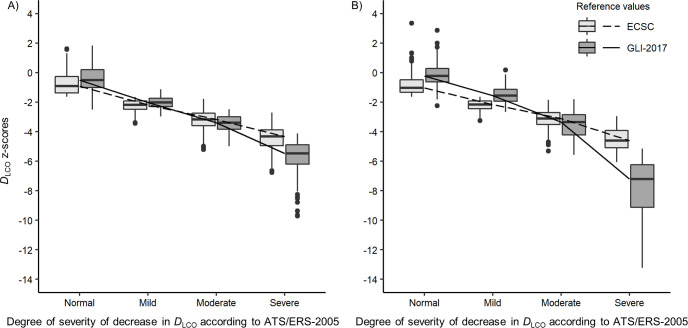
Box-plots of DLCO ECSC-93 and GLI-2017 z-scores by degree of decrease in DLCO according to ATS/ERS-2005 in (A) men and (B) women with ILD.Median values are represented by horizontal line within the boxes and interquartile ranges by box height. •: Outliers (values > 1.5 box lengths). DLCO was considered normal if the z-score was equal or greater than -1.645. The 2005 ATS/ERS recommendations for lung function test interpretation were used to define the degree of severity of DLCO impairment: “Mild” (DLCO > 60% predicted and below lower limits of normal), “Moderate” (DLCO > 40% and ≤ 60% predicted), “Severe” (DLCO ≤ 40% predicted) [18]. DLCO: Diffusing capacity of the lung for carbon monoxide; ECSC: European Community for Steel and Coal; GLI-2017: Global Lung function Initiative 2017 reference values; [6] ATS/ERS-2005: 2005 recommendations for lung function test interpretation from the American Thoracic Society (ATS) and the European Respiratory Society (ERS) [18].